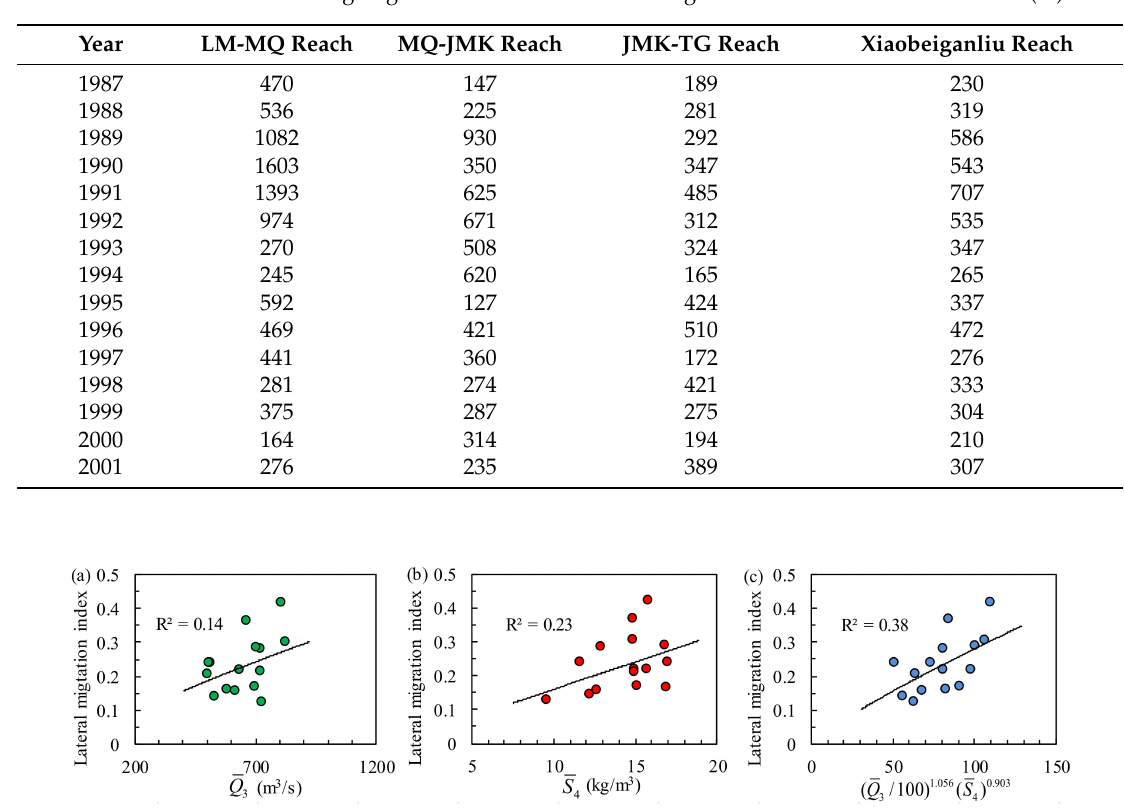
Table 1. Reach-scale thalweg migration distance in the Xiaobeiganliu reach and three sub-reaches (m).